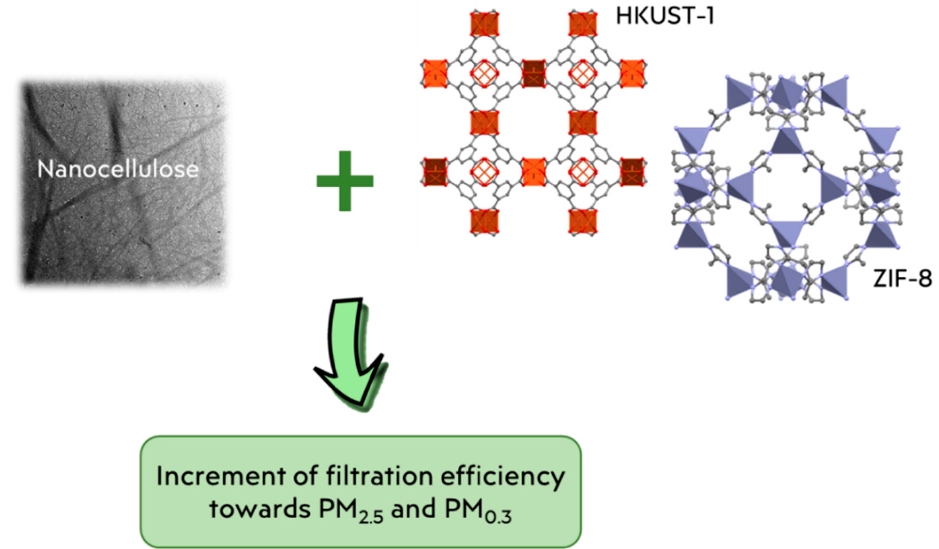
Figure 6. Representation of combined systems in which filtration efficiency is enhanced by the combination of the properties of nanocellulose and MOFs.